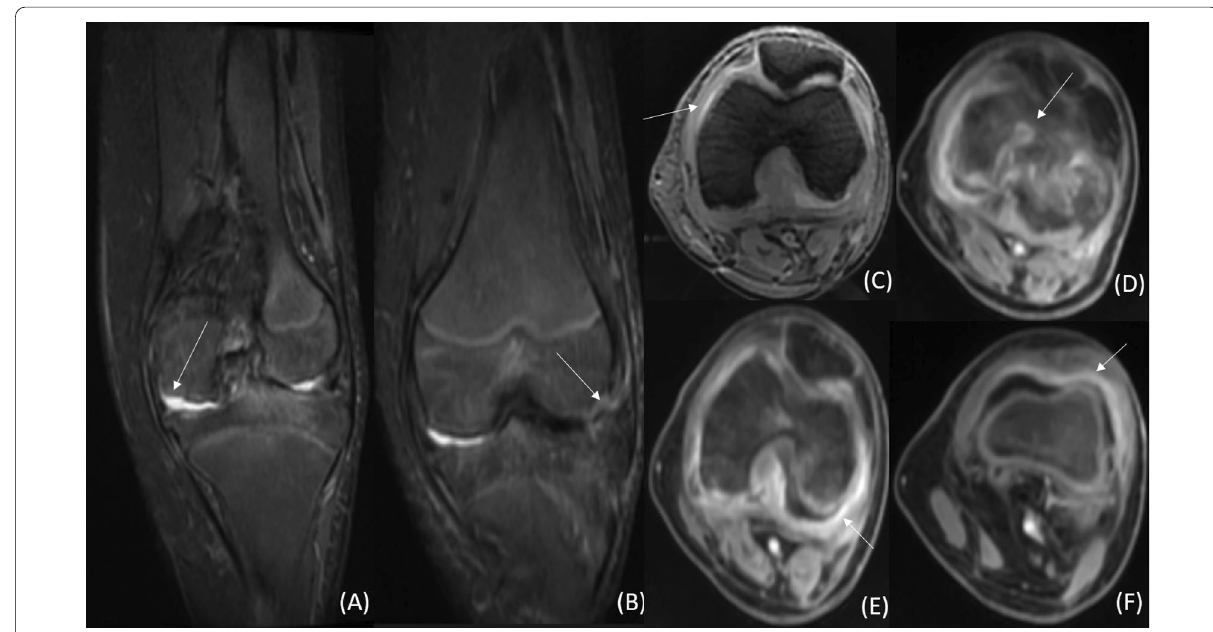
Fig. 11 Tubercular knee arthritis. MRI of a 16-year-old girl shows erosions in medial and lateral femoral condyles on coronal STIR images (white arrow in A and B ), there is mild joint effusion and marrow oedema in tibial plateau and intercondylar notch. Synovial thickening is seen on T2*GRE image (white arrow in C ), T1 contrast-enhanced axial images show rim enhancement of the erosion (white arrow in D ) and uniform synovial enhancement and thickening (white arrow in E and F )